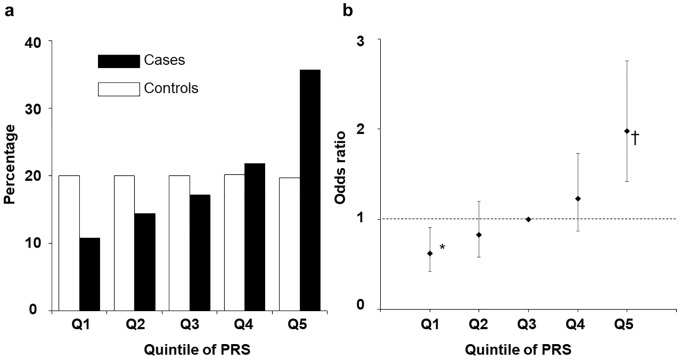
Percentage of subjects as well as the OR for pancreatic cancer according to PRS.(a) Distribution of the PRS in pancreatic cancer case and control subjects. (b) The OR for pancreatic cancer according to the quintiles of PRS. Vertical bars represent 95% CIs. The horizontal dashed line indicates the null value (OR = 1.0). *P < 0.05, †P < 0.01 versus Q3. The cutoffs for the quintiles of PRS in the control subjects were Q1 ≤ 0.58, 0.58 < Q2 ≤ 0.91, 0.91 < Q3 ≤ 1.12, 1.12 < Q4 ≤ 1.31, and Q5 > 1.31. OR values were calculated by logistic regression analysis with adjustment for cigarette smoking and family history of pancreatic cancer.